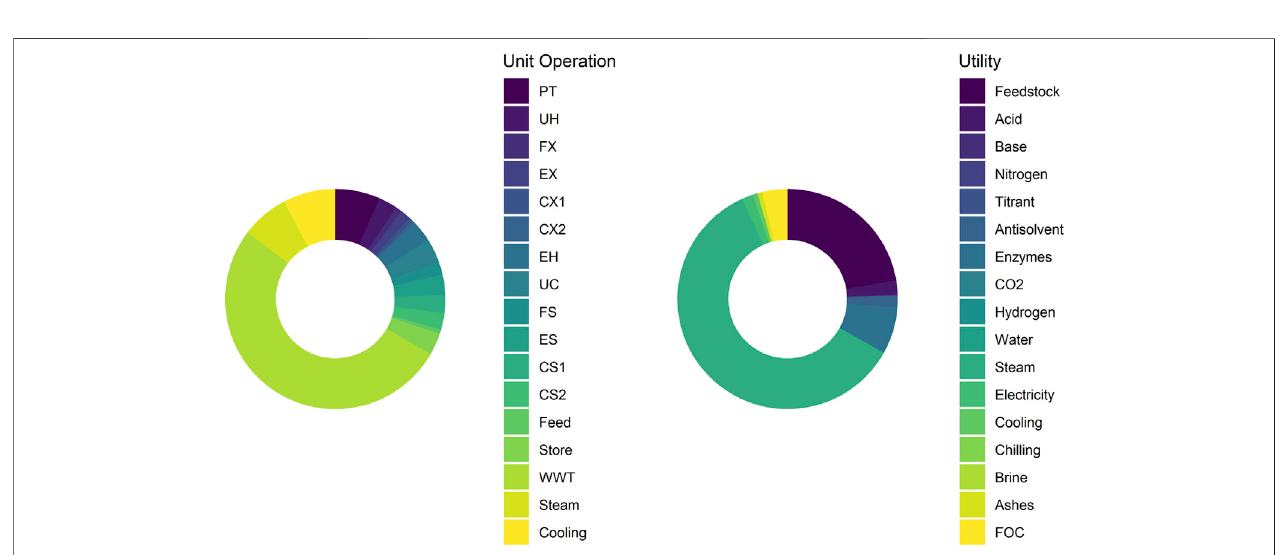
FIGURE 8 | Analysis of the composition of both FCI (left) and TPC